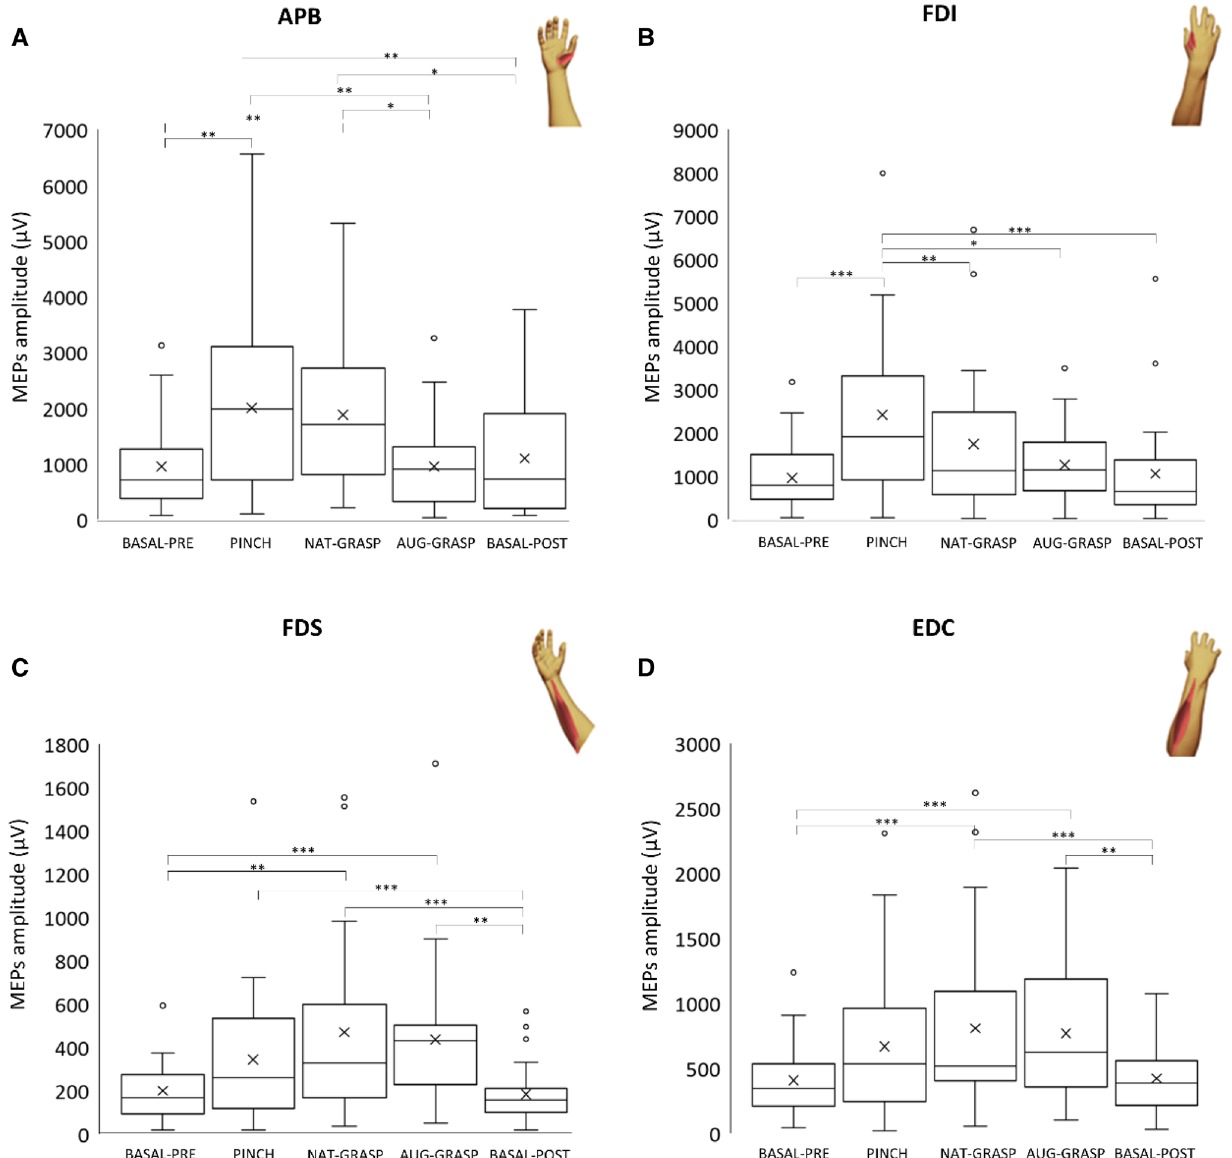
Figure 3. MEP amplitude changes at single-muscle level. ( A ) APB variation versus resting condition (BASAL- PRE); ( B ) FDI variation versus resting condition; ( C ) FDS variation versus resting condition; ( D ) EDC variation versus resting condition. Here and in the following figures, the following parameters of raw amplitude data distribution are indicated: mean and median values (the cross and the line within the box), the 25th and 75th quartiles (the borders of the box), the 5th and 95th percentiles (the extremes of the whiskers). Small circles indicate